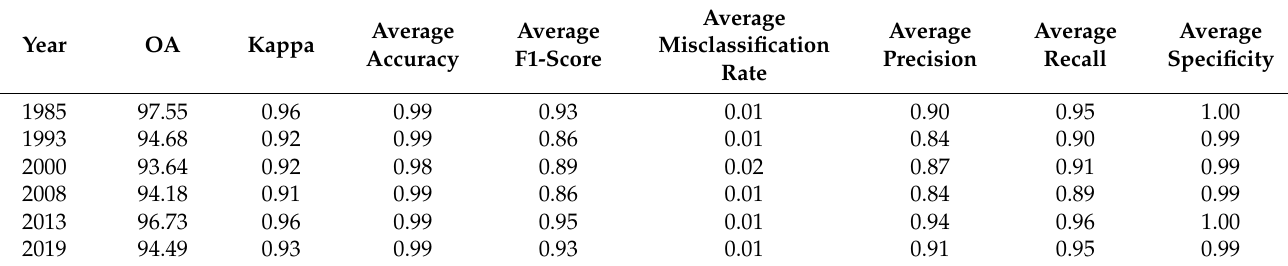
Table 6. Estimated error matrix of sample counts.